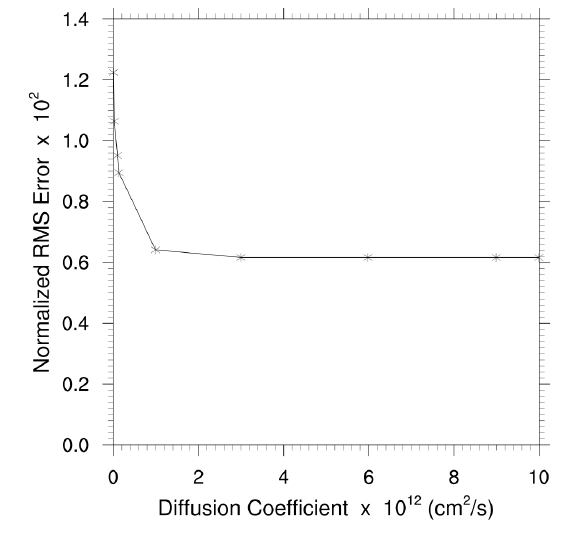
Figure 9. RMS Error for the case of 200 ◦